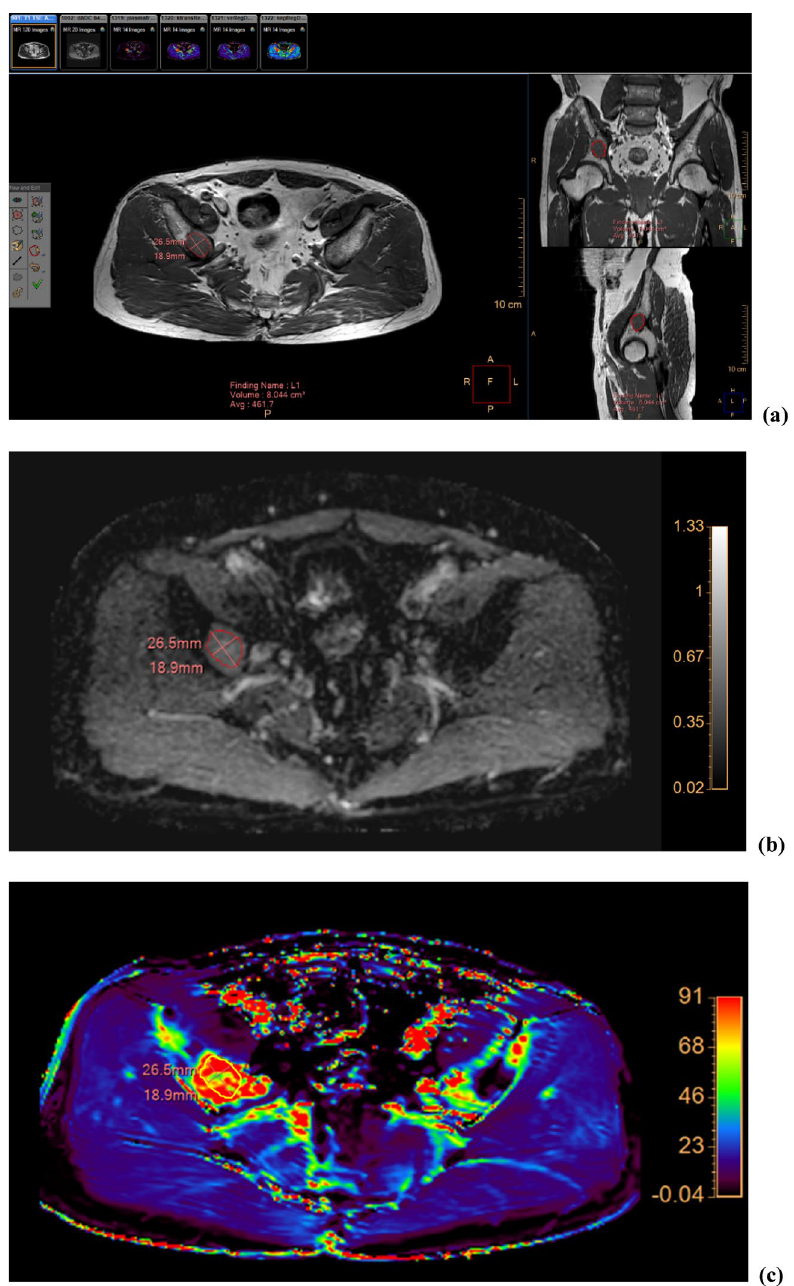
Figure 1. Images of a 64-year-old man with hepatocellular carcinoma showing metastasis to the right iliac bone. ( a ) The ROI was drawn within the lesion encompassing the whole tumor volume on axial T1-weighted images and reformatted coronal (right upper panel) and sagittal (right lower panel) images. The corresponding ADC map ( b ) and color-encoded overlay maps of the K trans ( c ), k ep ( d ), v e ( e ), and v p ( f ) are shown with ROIs and scale bars. ADC, apparent diffusion coefficient; K trans , volume transfer constant; k ep , rate constant; v e , volume fraction of the extravascular extracellular matrix; v p , blood plasma volume; ROI, region of